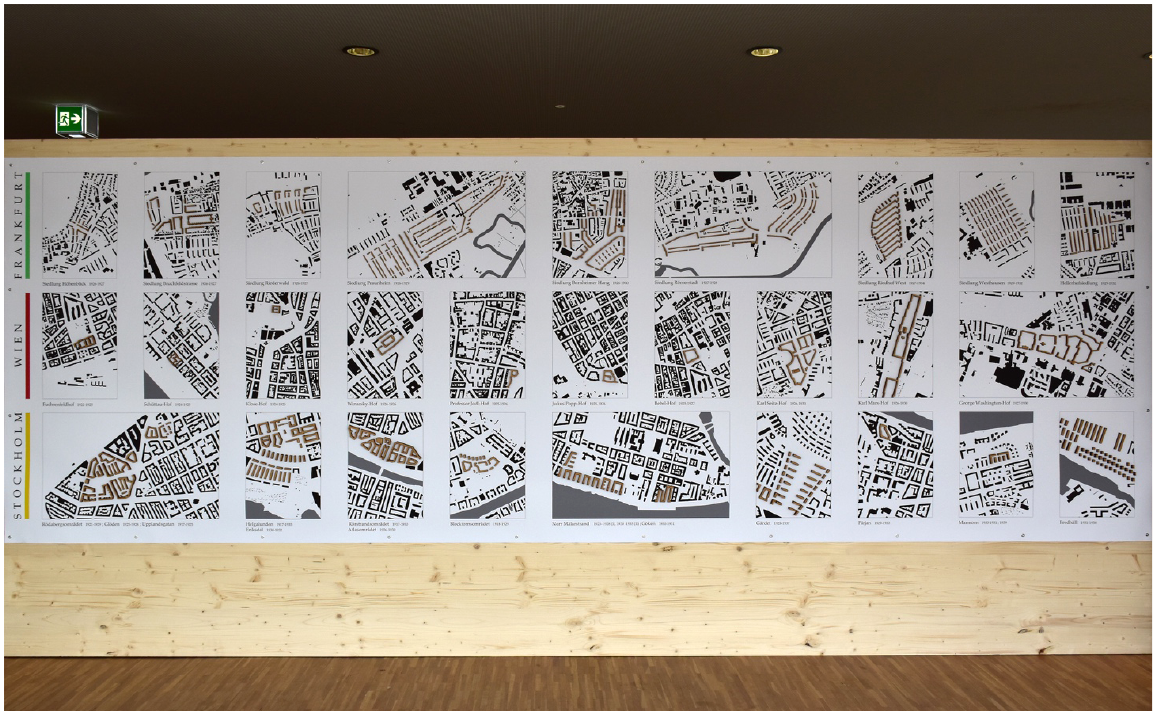
Figure 7. Section one: twenty-eight images of wooden architectural models of housing neighborhoods into the urban tis- sues. Source: Authors.